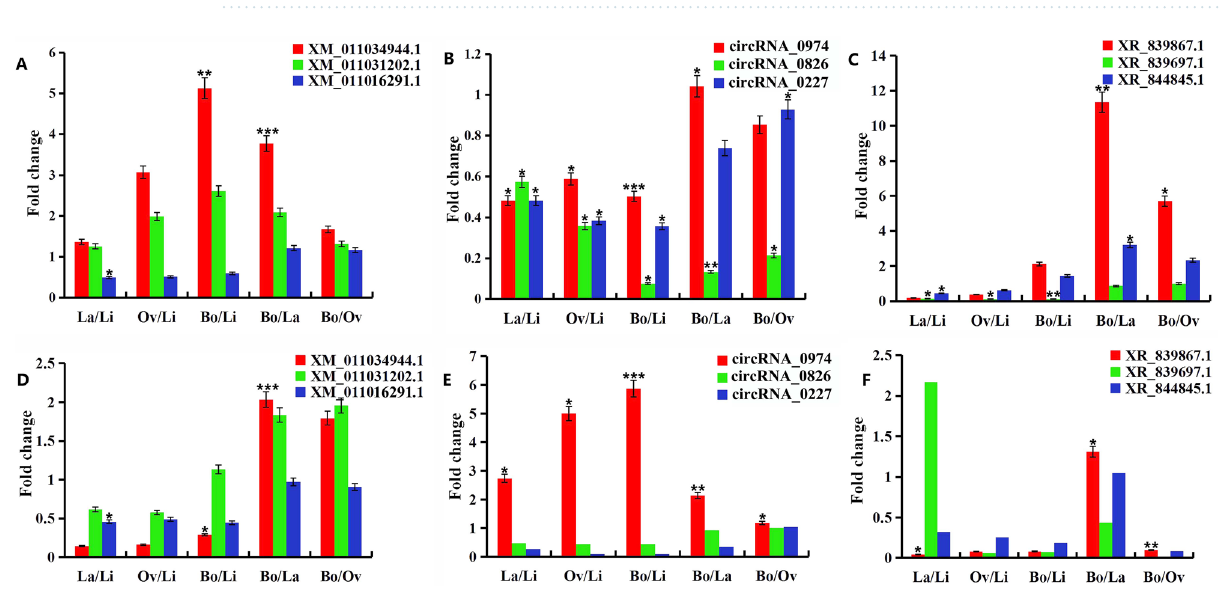
Figure 8. qPCR validation of the three kinds of RNAs in Li, La, Ov, and Bo leaves. ( A – C ) display the sequencing results; *P < 0.05, **P < 0.01, and ***P < 0.001 represent significant comparisons of sample pairs obtained using DESeq2. ( D – F ) display the corresponding RNA qPCR results; *P < 0.05, **P < 0.01, and ***P < 0.001 are the significance values of the comparison of sample pairs (For example Bo/Li) obtained by ‘f-test and t-test with EXCEL. Error bars indicate ± SD. This figure was generated by